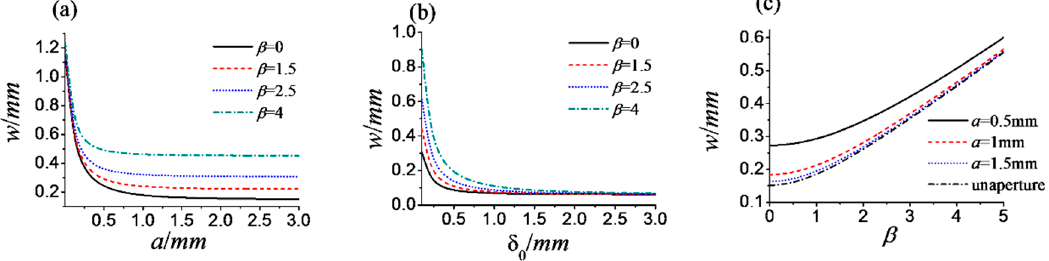
Figure 4. Effective beam waist width of an apertured BGCSM beams in the focal plane versus ( a ) aperture radius a , ( b ) transverse coherence width δ 0 , and ( c ) β . The other parameters were set as δ 0 = 0.2 mm in ( a ), a = 1.5 mm in ( b ), and δ 0 = 0.2 mm in ( c ).